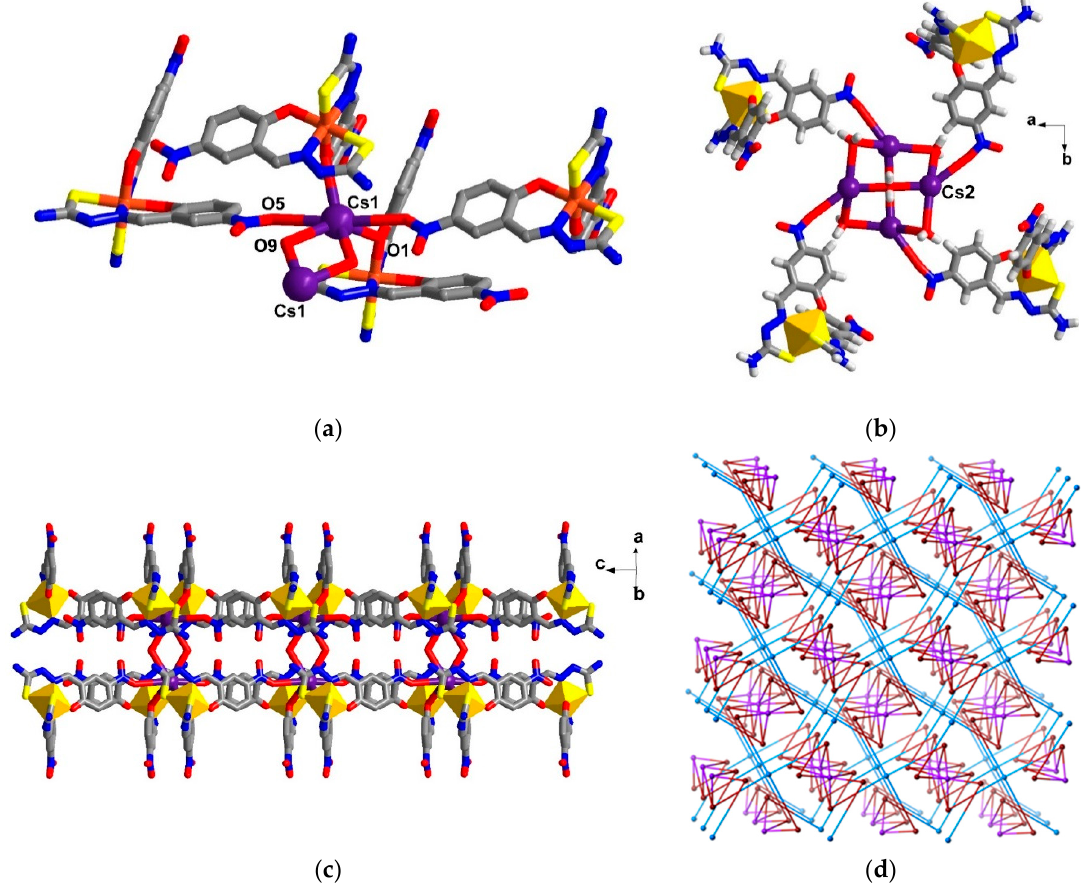
Figure 8. Representations of 6 show ( a ) the coordinating atoms surrounding Cs1 ( b ) the cluster of